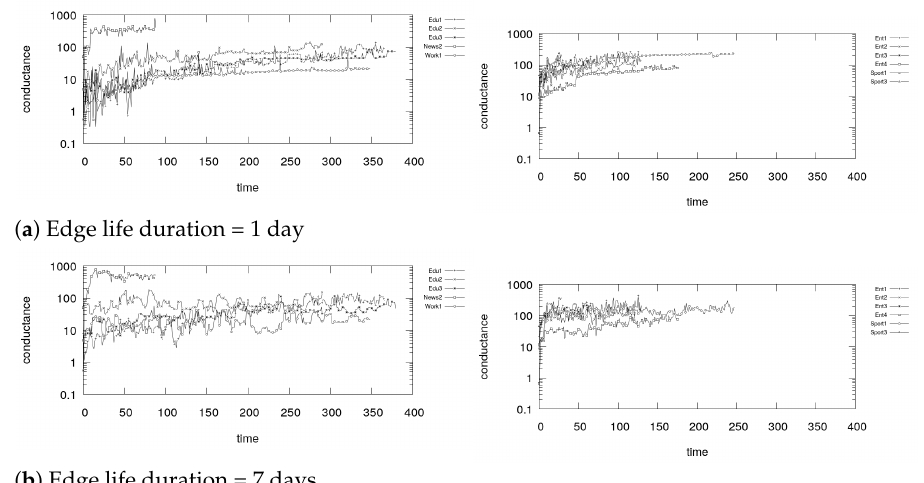
Figure 29. Conductance of communities detected by TILES.